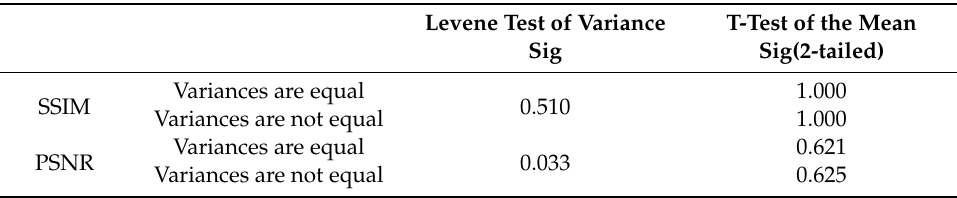
Table 5. T-Test of the model across